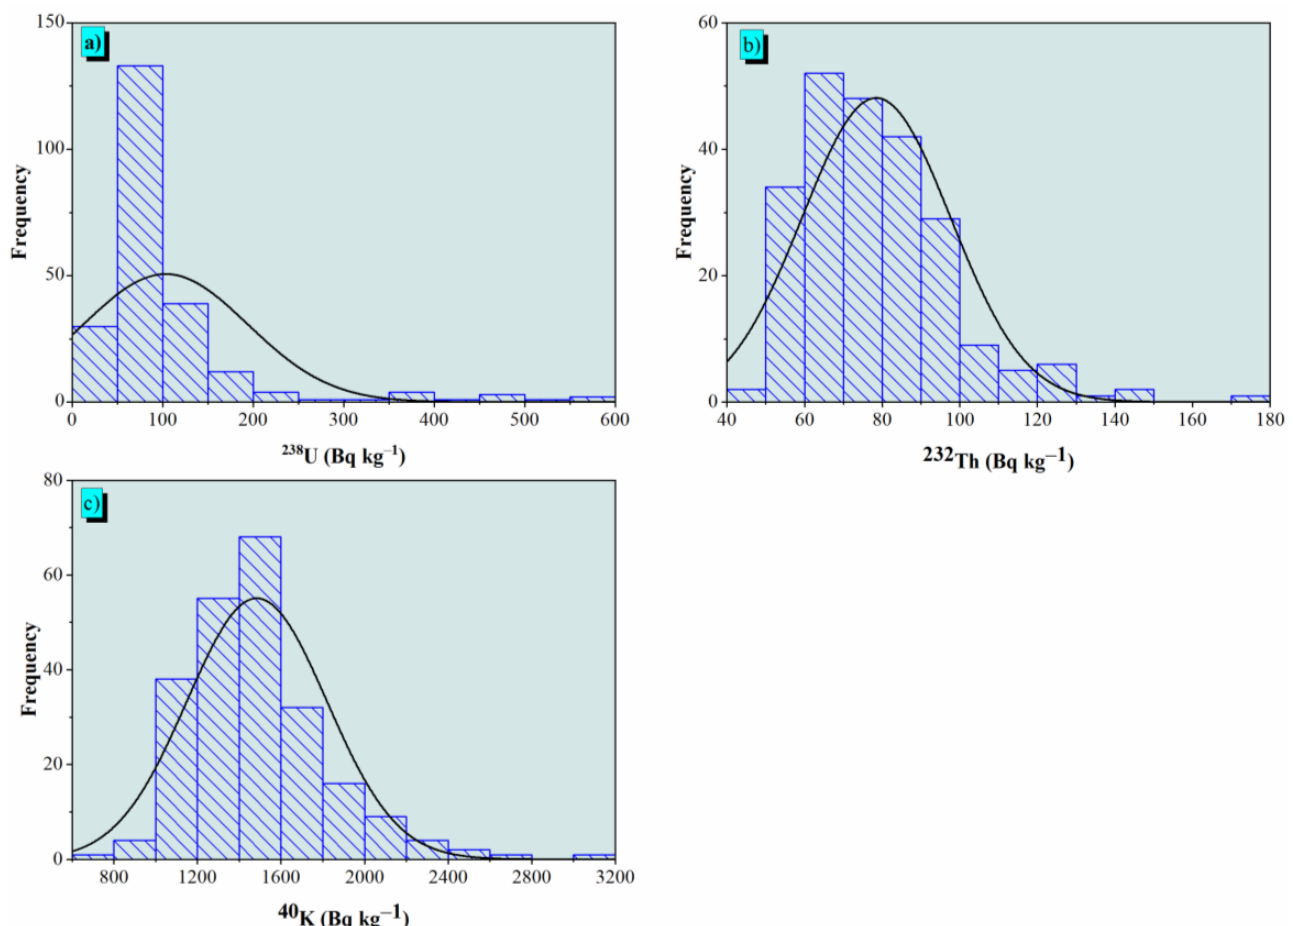
Figure 8. Distribution of the activity concentrations of 238 U, 232 Th, and 40 K in Bq kg −1 of the monzogranites in the Monqul area, north Eastern Desert, Egypt. Table 6. Comparison of 238 U, 232 Th, and 40 K activity concentrations in the Monqul area with numer- ous world